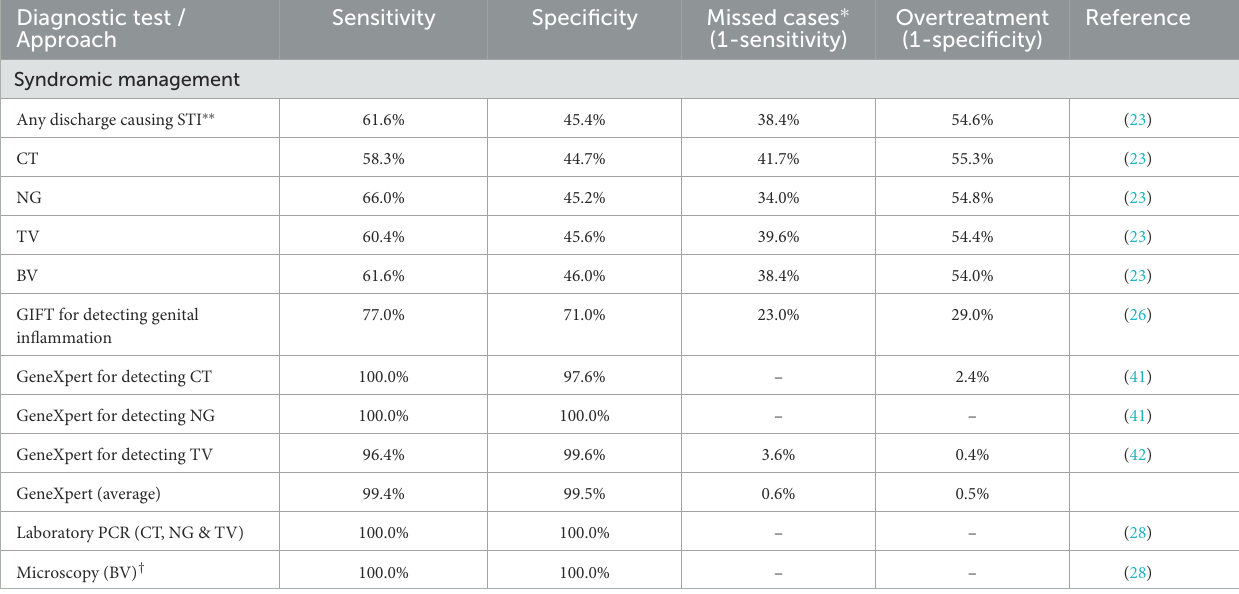
TABLE 1 Sensitivity and specificity of diagnostic tests and approaches and model strategies in detecting STIs and BV in reproductive aged women in South